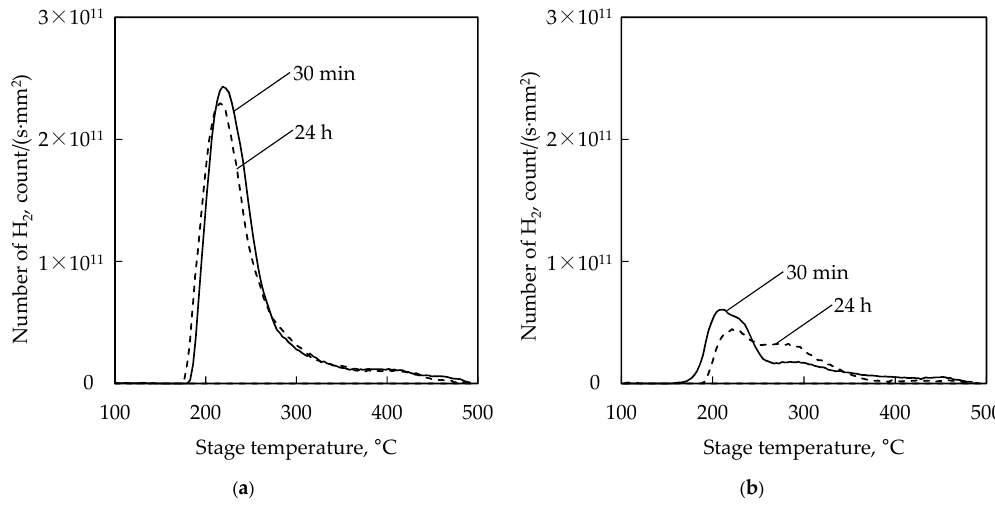
Figure 7. Change of the TDS spectrum with time in the atmosphere. After the treatments, Cu film was exposed to the atmosphere for 30 min and 24 h. The spectra show the H 2 desorption rate along with the increasing temperature. The temperature elevation rate was 60 °C/min. ( a ) H 2 desorption spectrum of H 2 /Ar plasma treated Cu; ( b ) H 2 desorption spectrum of citric acid treated Cu.